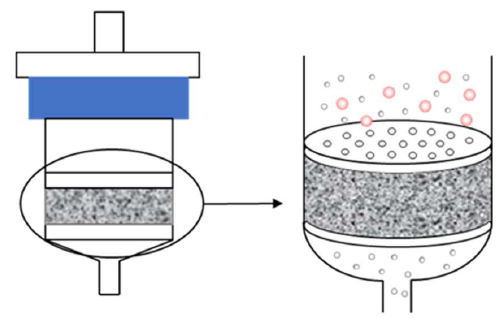
Figure 1. Schematic diagram of the mini-SPE.